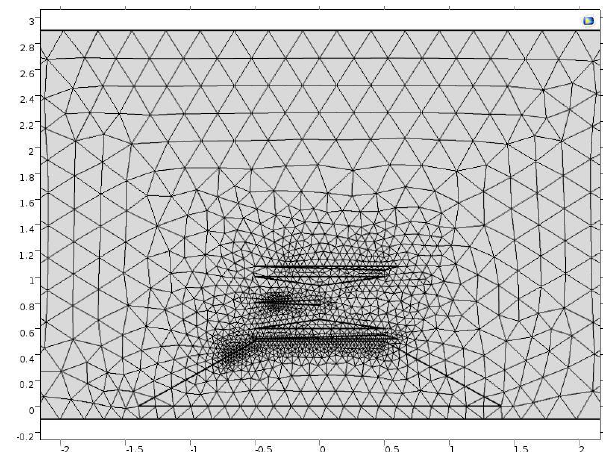
Figure 1. The three-dimensional model of the closed type